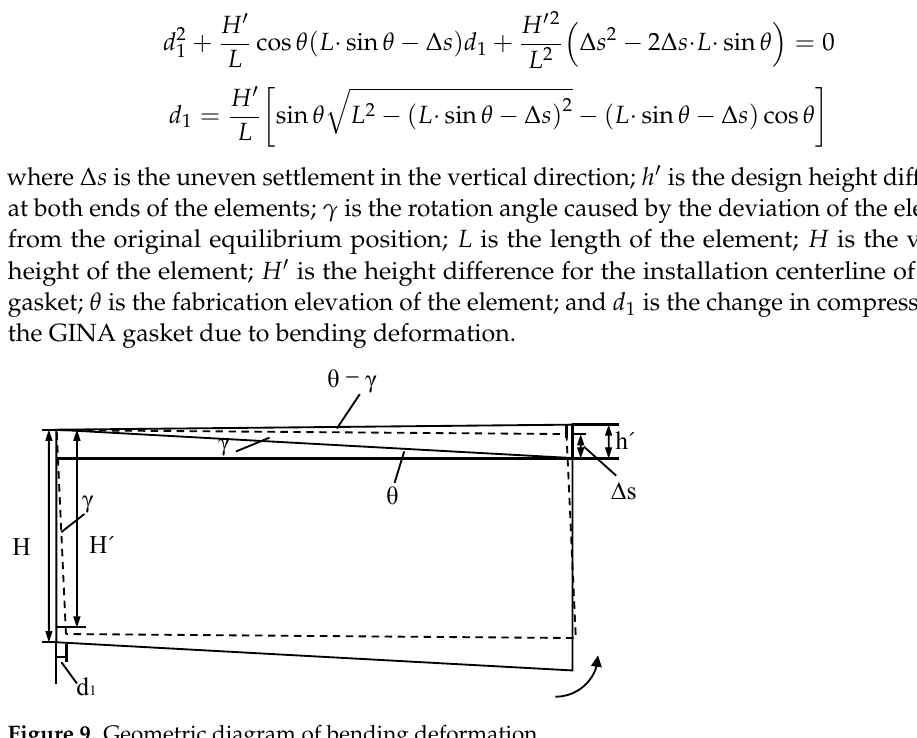
Figure 9. Geometric diagram of bending deformation.